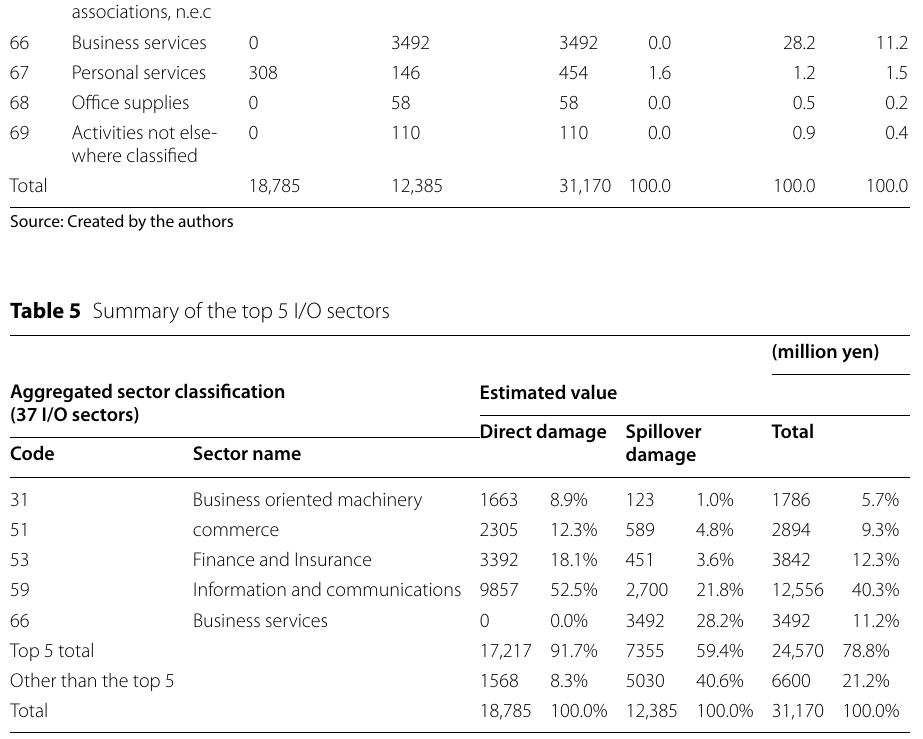
Source: Created by the authors